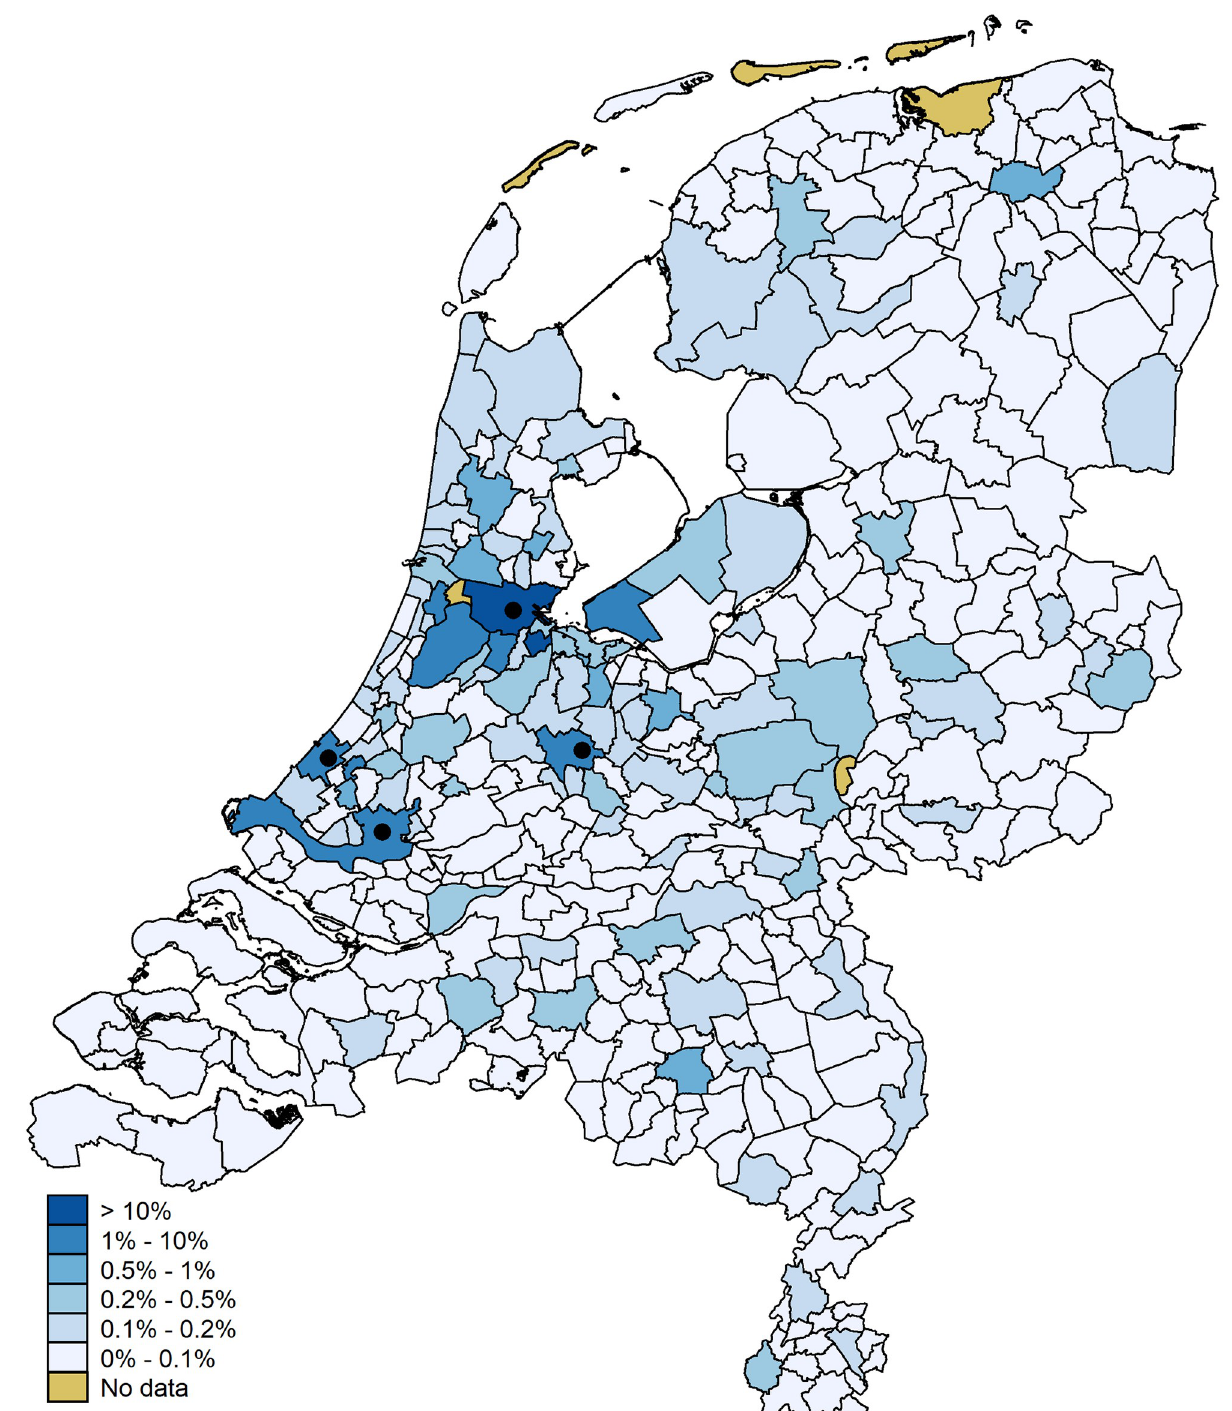
Fig 2. Hits to Amsterdam. Digital geometry (i.e., the shapefile) obtained from CBS/Kadaster [30]).